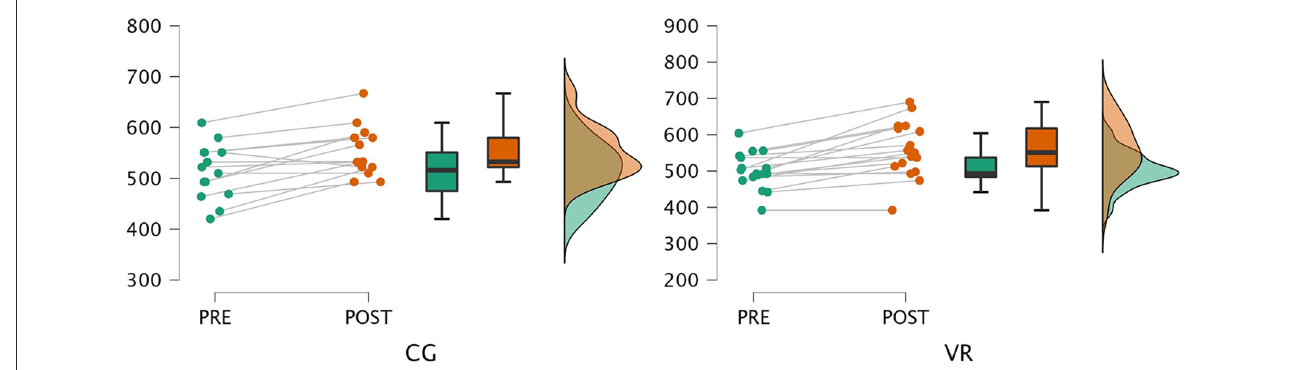
FIGURE3 Results of the 6-minute walk test.